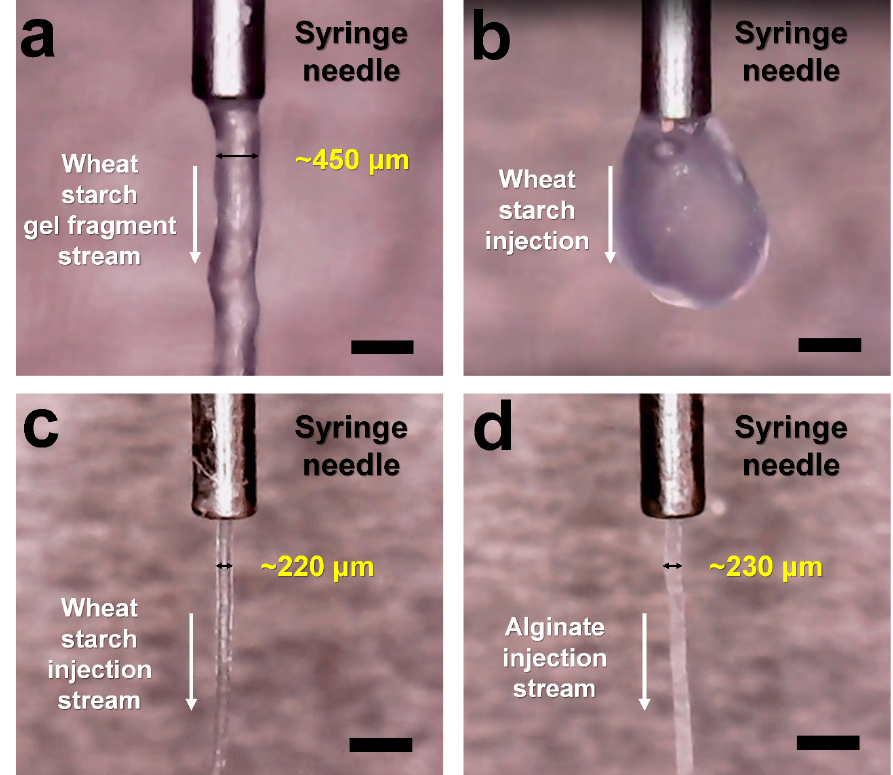
Figure 1. Snapshot of the injection stream of ( a ) 5% ( w / v ) WS gel fragment, ( b ) 5% ( w / v ) WS, ( c ) 14% ( w / v ) WS, and ( d ) 14% ( w / v ) alginate. WS and alginate delivery media were extruded from a syringe needle with an inner diameter of 168 μ m at room temperature. The scale bar indicates 718 μ m.